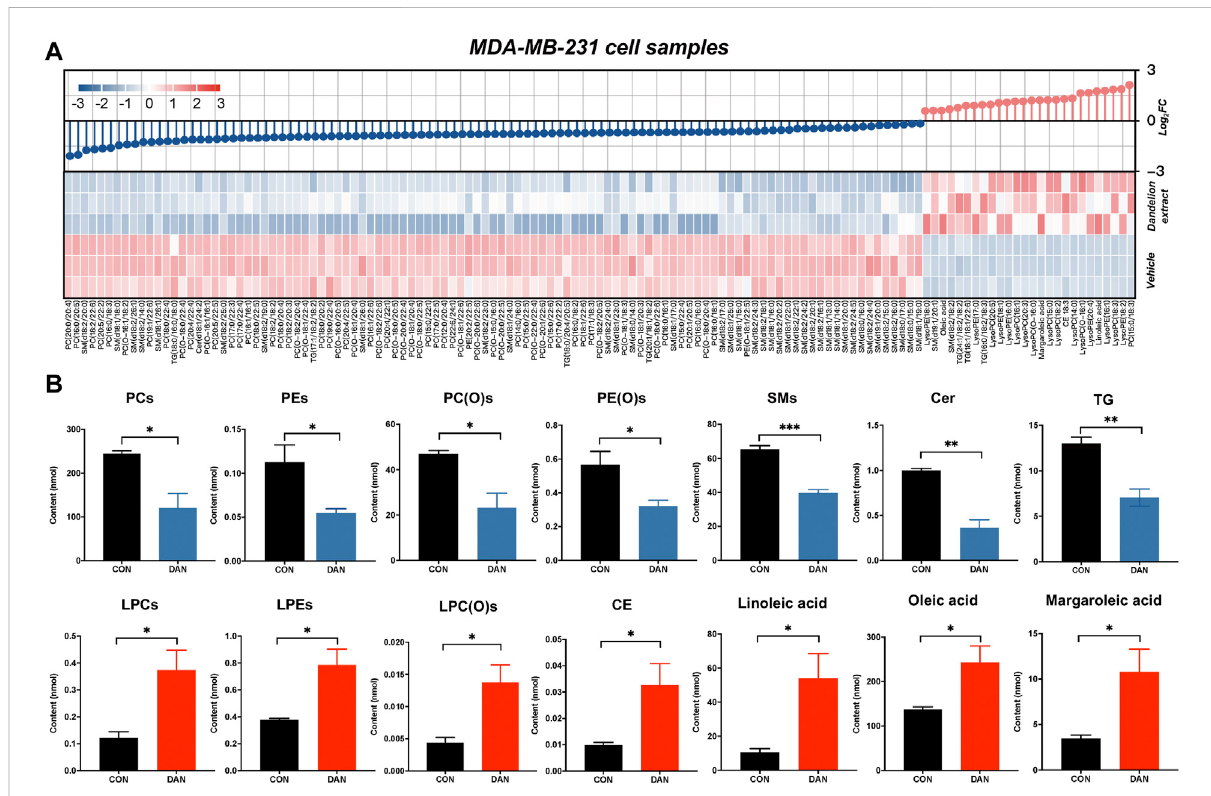
FIGURE 4 The lipidomics pro fi les of MDA-MB-231 cells after dandelion extract treatment. (A) The heatmap and change dumbbell charts of the signi fi cantly changed metabolites of untargeted lipidomics. (B) The changes of the signi fi cantly differential metabolites of untargeted